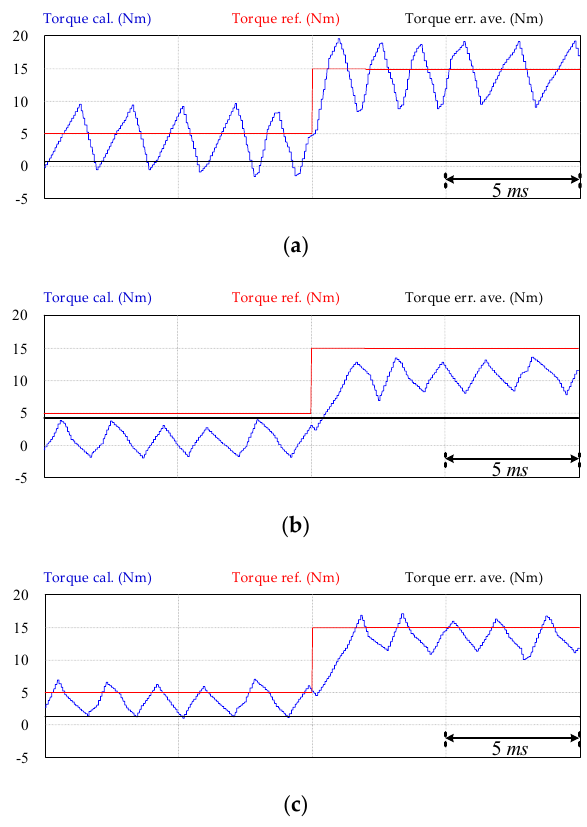
Figure 11. Simulation zoomed results of the transient-state operation: ( a ) conventional four-level HTC at 150 r/min; ( b ) conventional four-level HTC at 600 r/min; ( c ) proposed four-level HTC at 600 r/min.